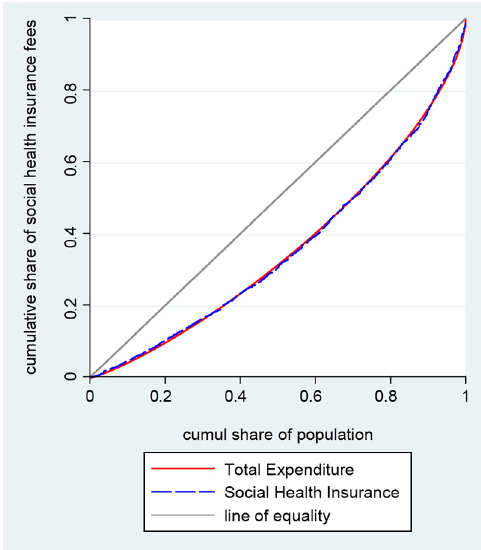
Figure 8. Concentration